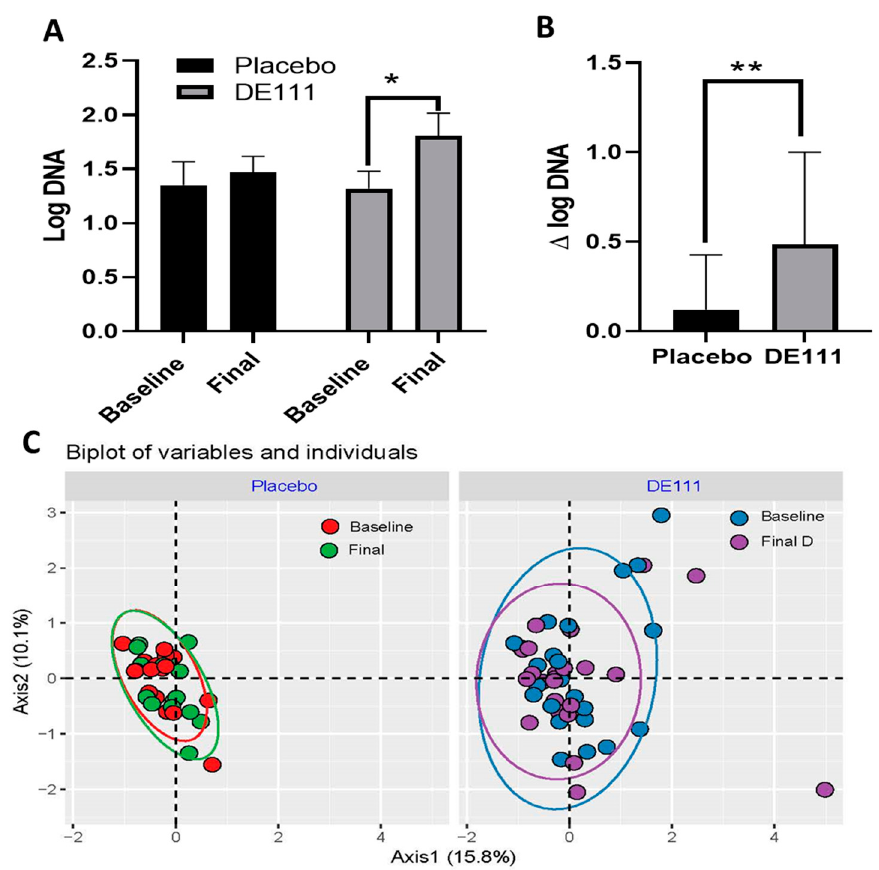
Figure 3. Levels of B. subtilis DNA detected in fecal samples collected pre- and post-intervention ( A ) and the change in logDNA from baseline between the two intervention groups ( B ) indicate that DE111 consumption increases B. subtilis in the GI tract. However, four weeks of DE111 consumption did not significantly alter the composition and structure of the gut microbiota ( C ). Error bars represent ± SEM. * indicates p -values <0.05 and ** indicate p -values <0.01. Ellipses in the PCoA represent the 95% CI.